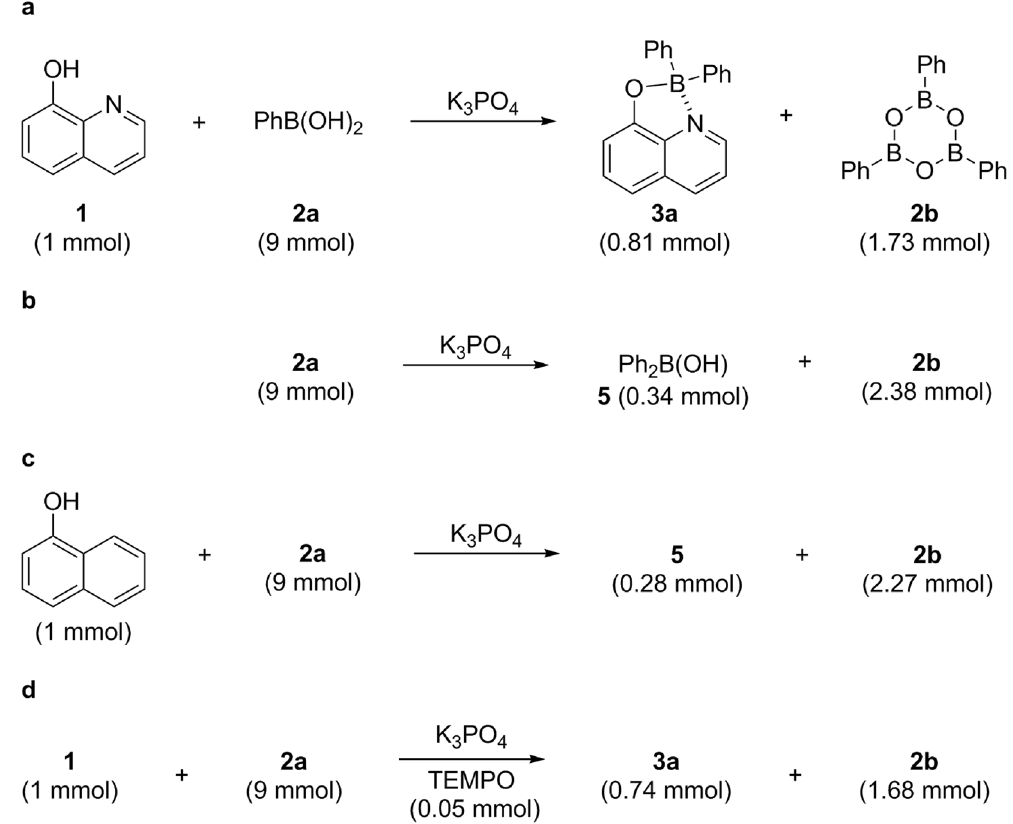
Figure 5. Control experiments. All reactions were performed with K 3 PO 4 (3.0 mmol) in 1,4-dioxane (0.02 M) at 110 °C for 20 h. ( a ) The reaction suggests that product formation is more likely due to the disproportionation of phenylboronic acids facilitated by the presence of the chelate ligand under basic conditions. ( b ) This reaction demonstrates that base-induced disproportionation of boronic acids can also occur even without chelate ligand, but in lower grade. ( c ) The reaction indicates an initial formation of four-coordinated boron species assisted by a B → N dative bond is crucial for product formation. ( d ) Addition of the radical scavenger TEMPO proved to show a negligible impact on the reaction indicating that the reaction presumably proceeds by the ionic